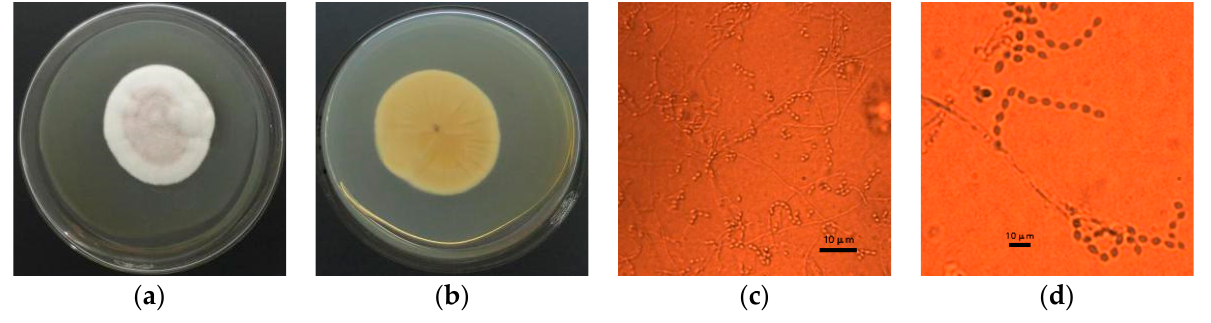
Figure 1. Morphological characteristics of PBF7. ( a ) Positive side of culture medium colony. ( b ) Back of the culture medium colony. ( c ) Micrograph (400×). ( d ) Micrograph (1000×).